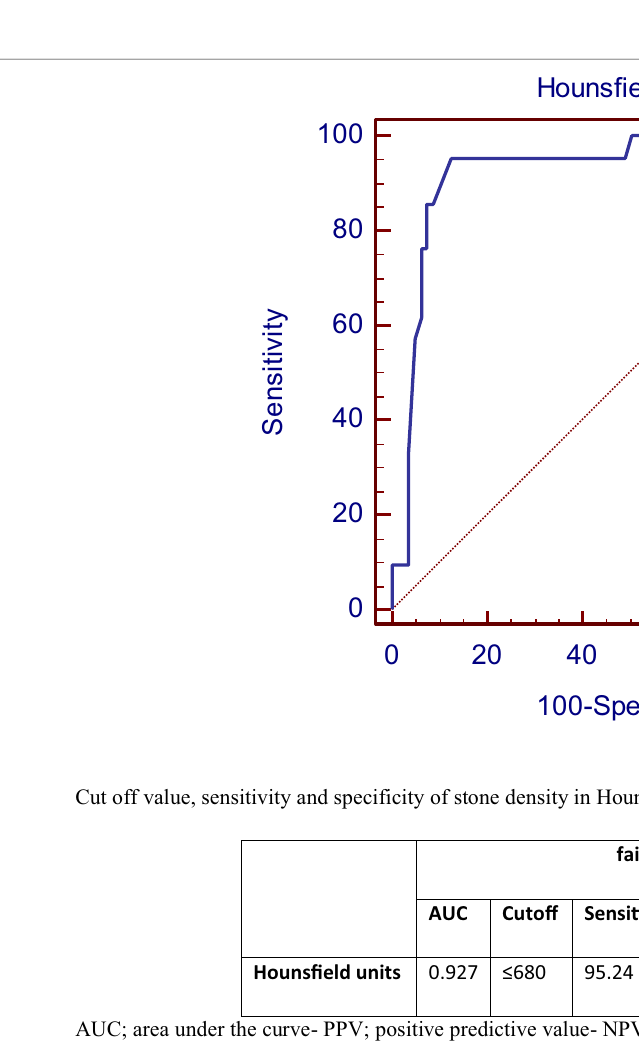
Stone radio-opacity by PKUB and its attenuation value by NCCT could successfully predict its calcium oxa- late monohydrate, struvite, and urate composition and hence its treatment option. However, the chemical stone analysis is still required as most stones are mixed.